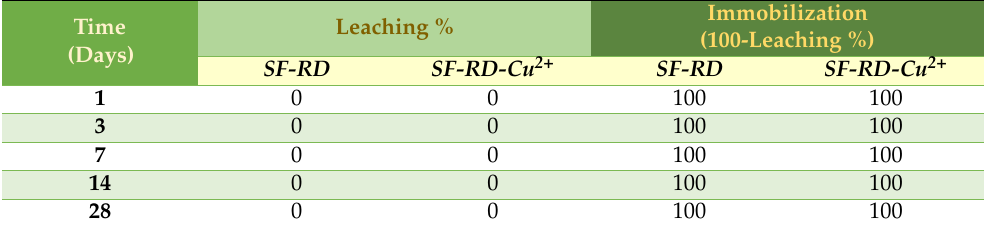
Figure 9. UV–VIS absorption spectra of reactive red 195 dyeing bath effluent and different leachate solutions for: ( A ) SF-RD geopolymer mix and ( B ) SF-RD-Cu 2+ , after different curing periods. Table 4. Leaching % and immobilization values of reactive red 195 dyeing bath effluent in leachate solutions of different geopolymer mixes after different curing